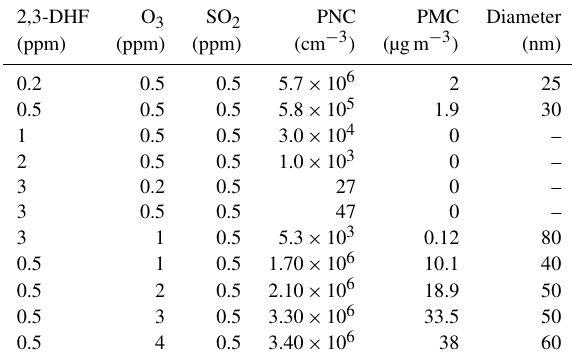
Table 1. Initial concentrations of reactants and SOA data for the ozonolysis reaction of 2,3-DHF. PNC, PMC and diameter reported values are the maximum data registered for each magnitude dur- ing the experiment. All the experiments reported in this table were carried out under RH =